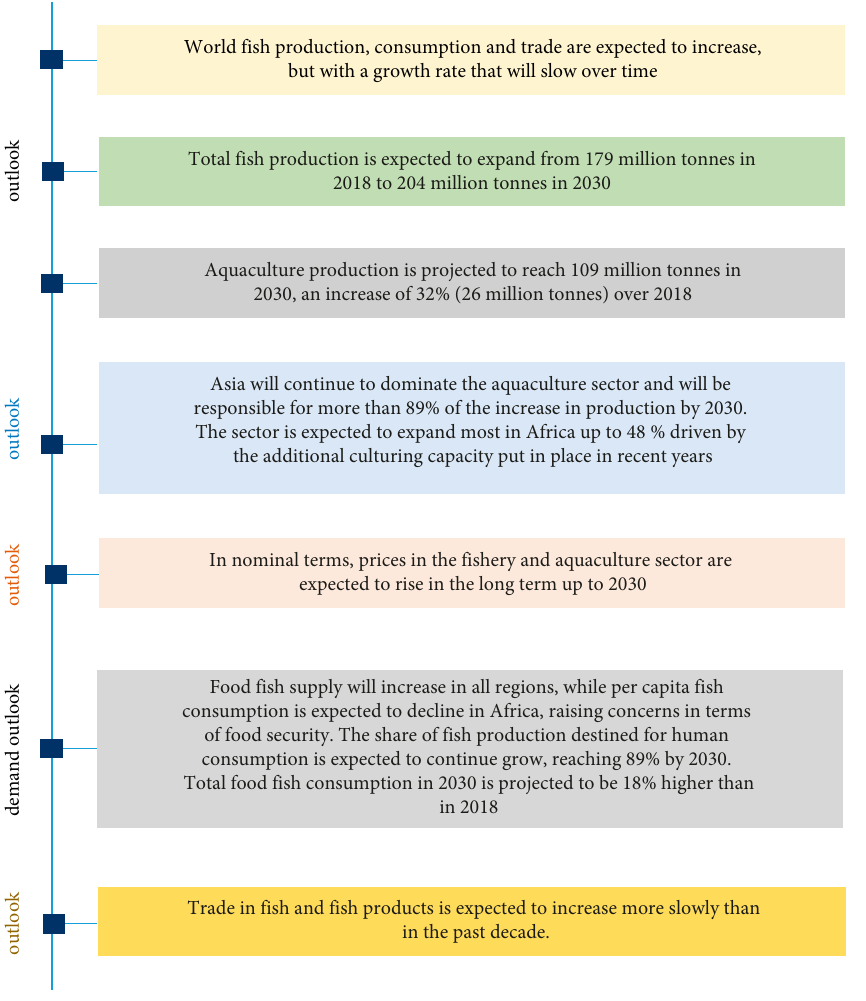
Figure 2: General prediction on future of world aquaculture and fisheries sector as published by FAO. Reference [3].